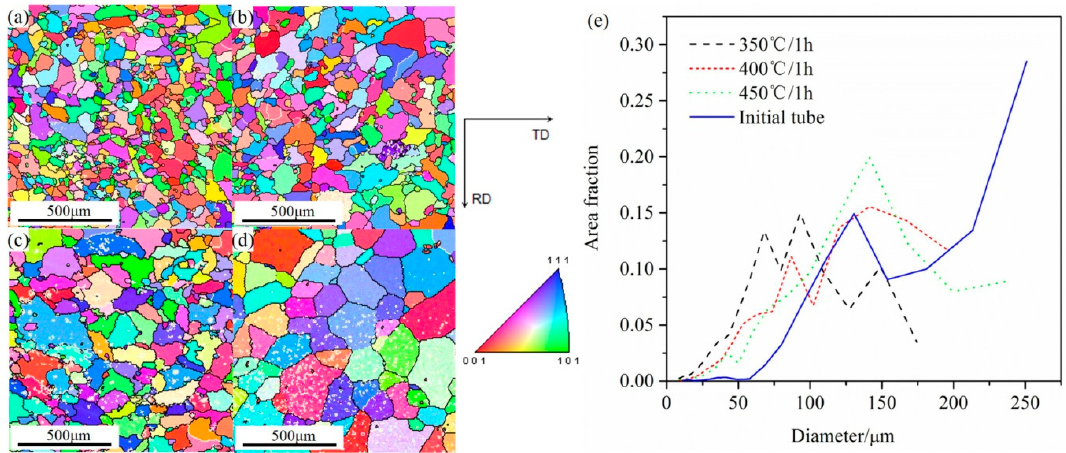
Figure 3. EBSD orientation maps of spun tube after annealing at ( a ) 350; ( b ) 400 and ( c ) 450 °C for 1 h; and ( d ) that of the initial tube; ( e ) Grain size distribution of each tube. Table 1. Grain size analysis of tubes prepared with different grain sizes.